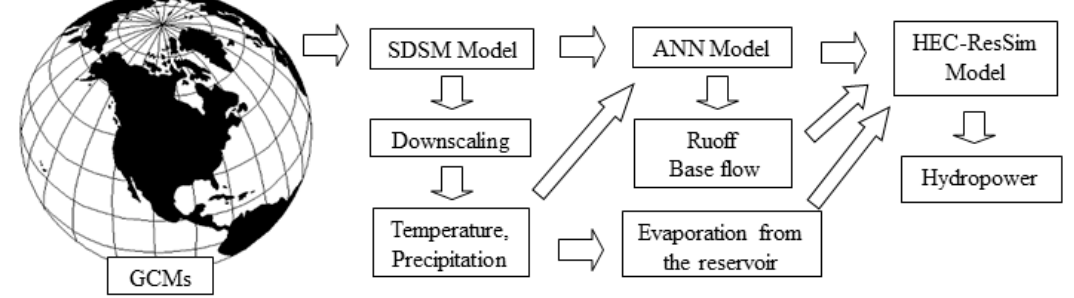
Figure 1. Methodology of climate change impact assessment on hydropower generation.